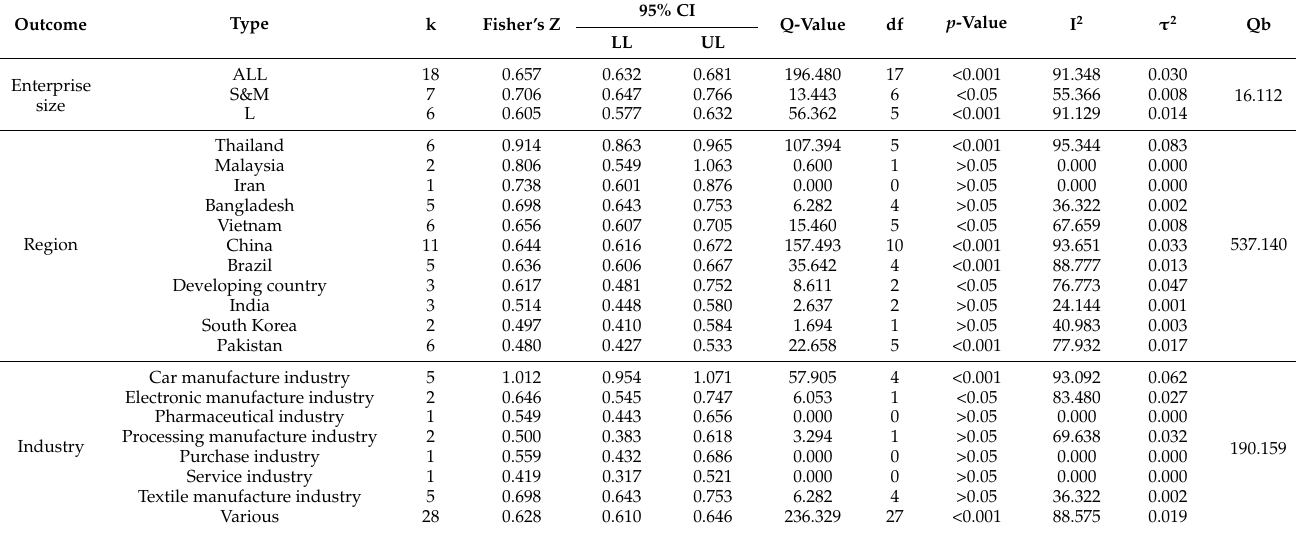
Table 5. Moderator’s analysis